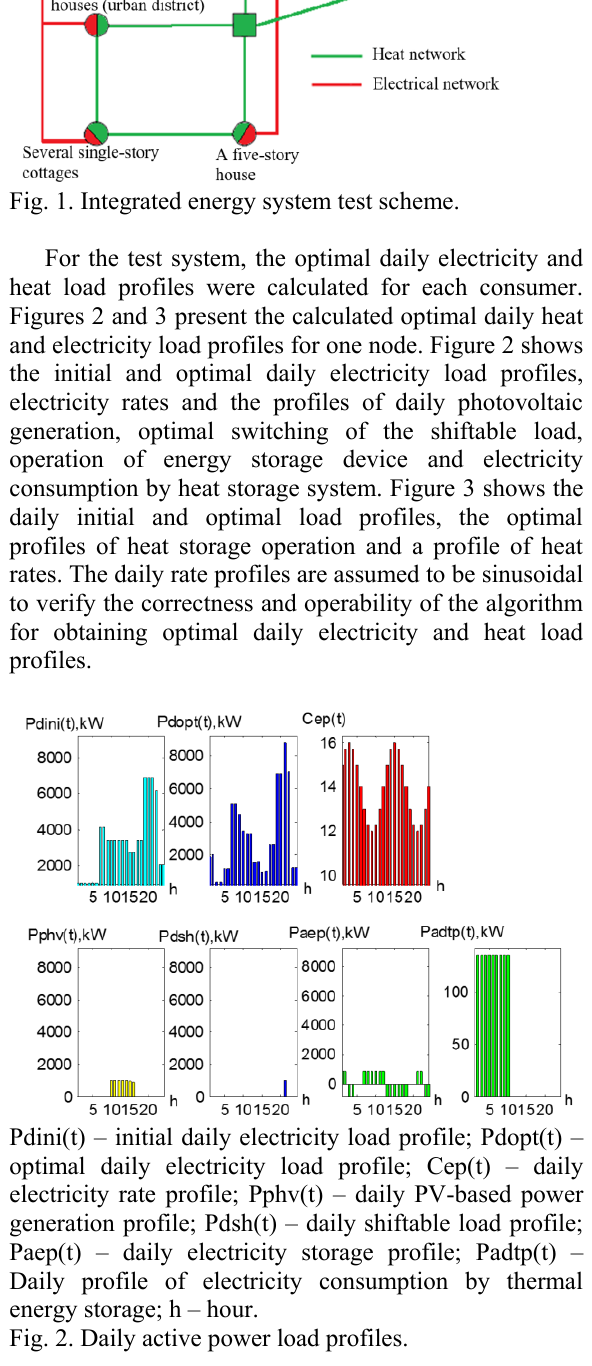
Fig. 2. Daily active power load